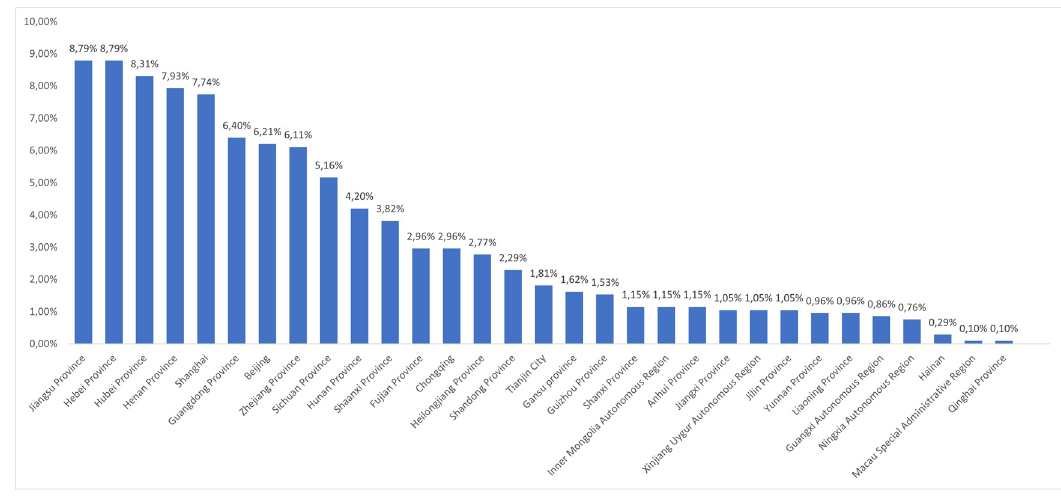
Figure 6: Geographical scope of survey respondents.